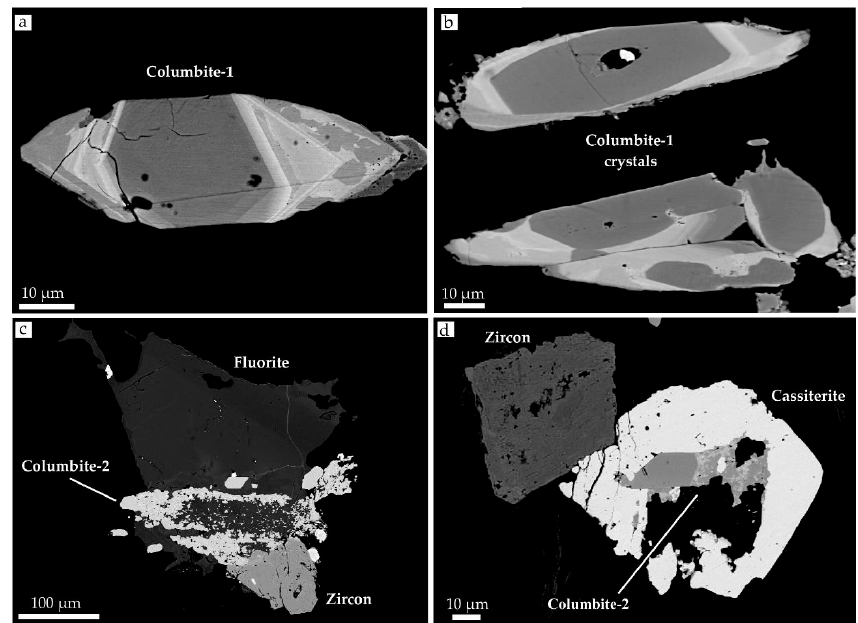
Figure 5. BSE images of columbite from the Desemborque Pluton showing the textural and compositional variations within crystals; ( a ) Euhedral columbite-1 crystal displaying convolute zoning with BSE-dark cores and BSE-bright and partially-spotted rims in syenogranite (Sample GUA − 50C); ( b ) euhedral and subhedral columbite-1 grouped crystals showing zoning patterns with inward/irregular contact between the core and rim zones in the greisen (Sample GUA − 08b). Of note, mostly crystals show partially corroded margins; ( c ) irregular intergrowths of columbite-2 replacing fluorite which occur in reaction texture with zircon in syenogranite (Sample GUA − 53); ( d ) anhedral columbite-2 crystal with a patchy texture that occurs along cavities of cassiterite showing partial replacement of its crystals rims in syenogranite (Sample GUA − 36).